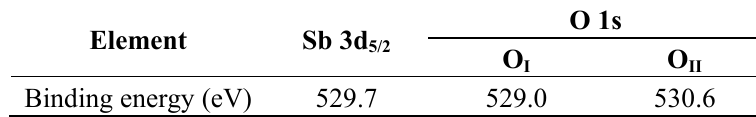
Table 1. XPS data corresponding to Figure 4d.